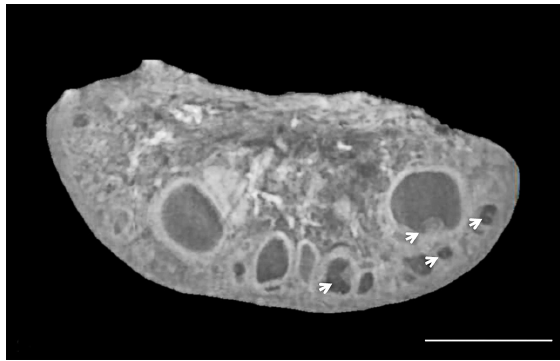
Figure 4 - MicroCT image showing oocytes inside antral follicles (white arrows) in the ovary of a queen. Barr = 2